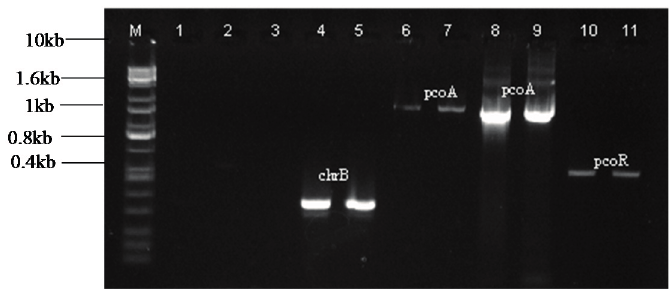
Figure 2. PCR amplification of chrB, pcoA and pcoR genes from the isolates Pseudomonas sp. KR23, Lysinibacillus sp. KR25 and E. coli KR29. The amplicons were visualized on a 1% agarose gel. Lanes represent the following: M . KAPA Universal Ladder; 1 . Negative control for chrB primers; 2 . Negative control for pcoA primers; 3 . Negative control for pcoR primers; 4 . chrB_23; 5 . chrB_23; 6 . pcoA_25; 7 . pcoA_25; 8 . pcoA_29; 9 . pcoA_29; 10 . pcoR_29 and 11 .